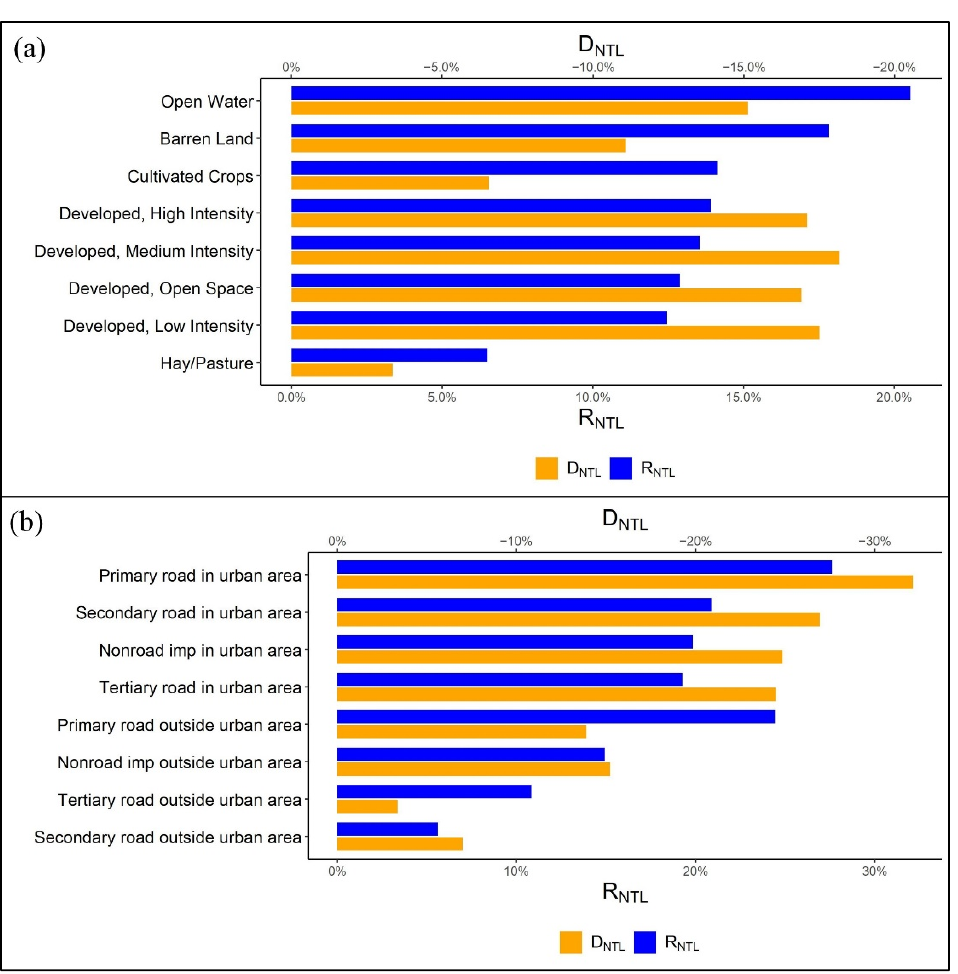
Figure 10. ( a ) Negative D NTL and R NTL in NLCD 2011 Land Cover classification; ( b ) Negative D NTL and R NTL in NLCD 2011 Developed Imperviousness Descriptor